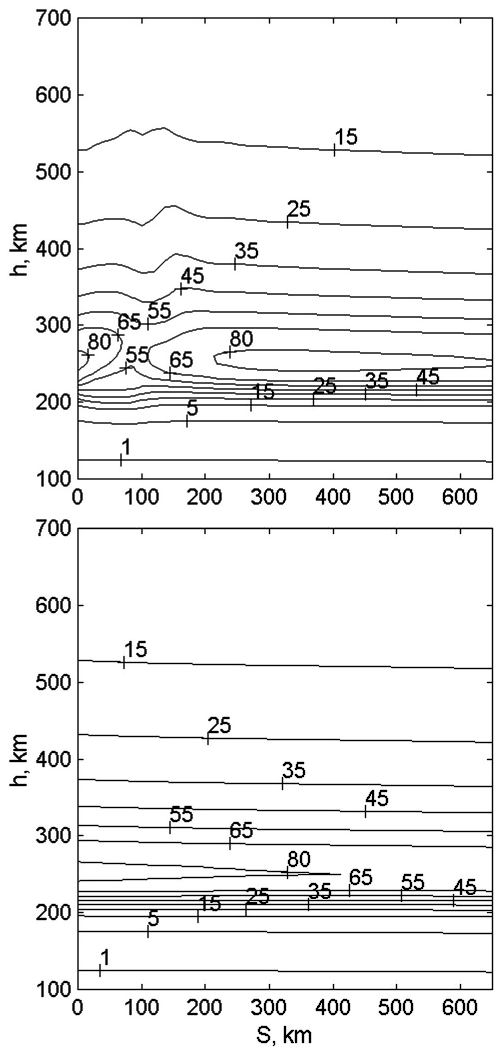
Fig. 14. The calculated isolines of the electron concentration (in units of 10 4 cm − 3 ) over the considered part of the convection tra- jectory obtained in the daytime under natural conditions without HF heating (bottom panel) and on condition that the powerful HF wave has the frequency of 7.0MHz (top